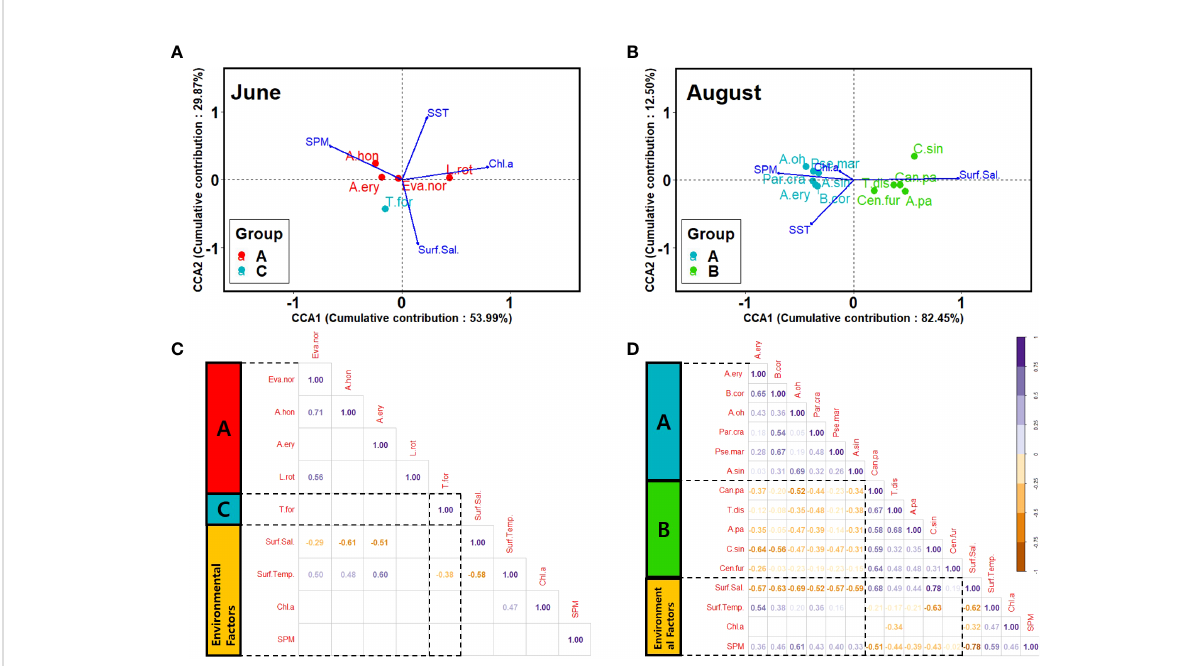
FIGURE 6 Results of canonical correspondence analysis (CCA) and correlation analysis. The correlation analysis between indicator species and environmental factors in this study ( p <0.05). (A, C) June; (B, D) August. SST, Sea surface temperature; Eva. nor, Evadne nordmanni ; A. hon, Acartia hongi ; A. ery, A. erythraea ; L. rot, Labidocera rotunda ; T. for, Tortanus forcipatus ; A. pa, A . paci fi ca ; A. oh, A . ohtsukai ; C. sin, Calanus sinicus ; Can. pa, Canthocalanus pauper ; B. cor, Bestiolina coreana ; Par. cra, Parvocalanus crassirostris ; T. dis, Temora discaudata